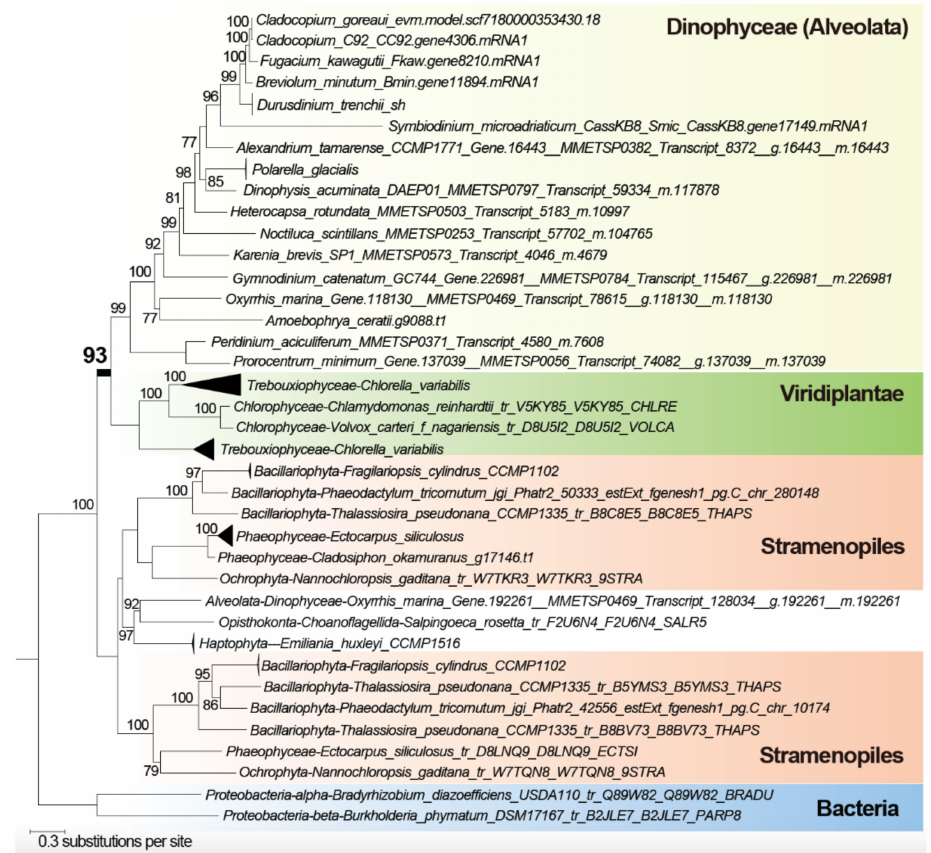
Figure 4. Maximum likelihood tree of putative sulphate transporter indicating a Viridiplantae origin in dinoflagellate genes. The ultrafast bootstrap support of IQ-TREE2 is shown at each internal node; only values ≥ 70% are shown. Unit of branch length is the number of substitutions per